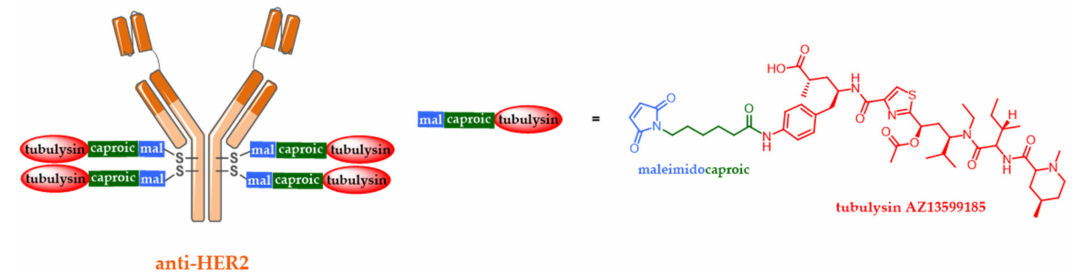
Figure 6. Homogeneous ADC with a DAR 4 comprising a biparatopic anti-HER2 antibody conjugated to a tubulysin derivative via a classical maleimidocaproic